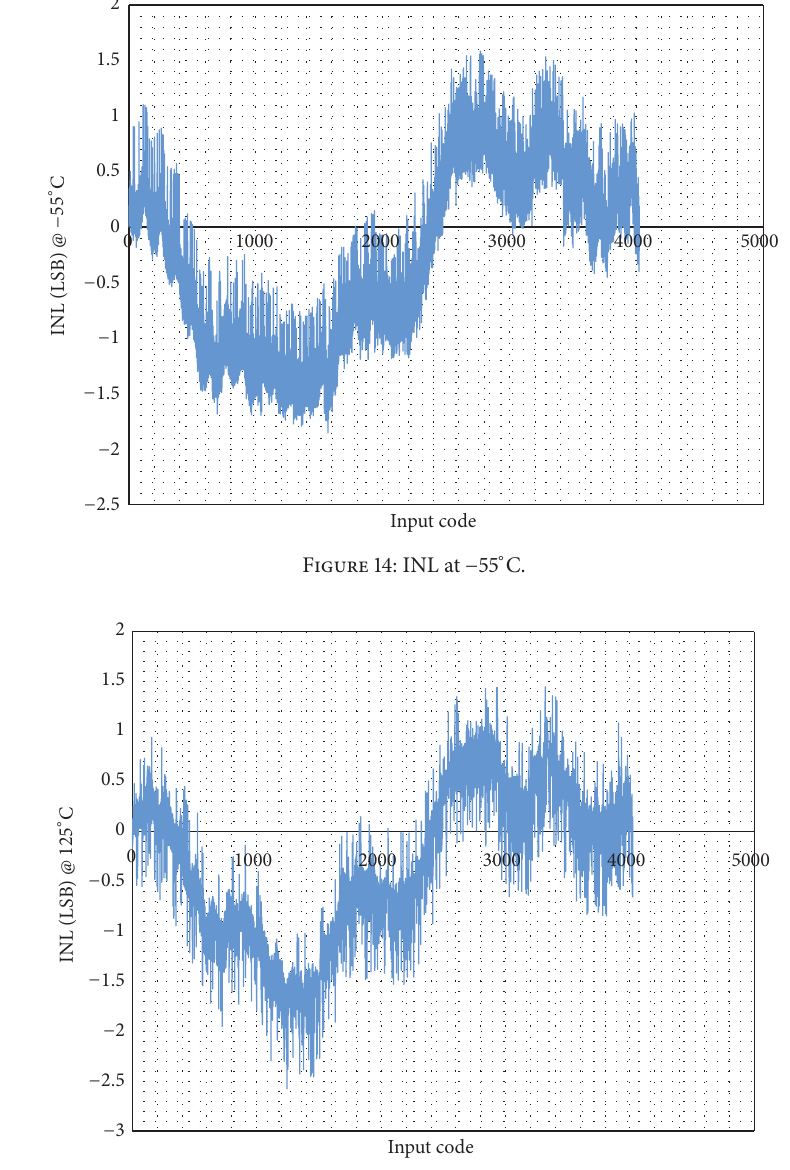
Figure 15: INL at 125 ∘